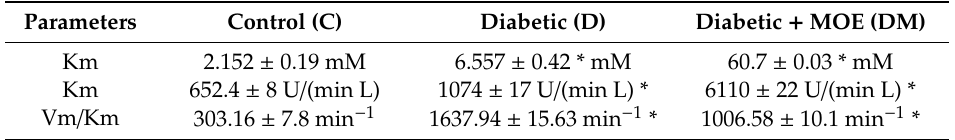
Figure 2. Calculation of Km and Vm from substrate concentration versus time plots. The image shows a representative trace of five repetitions for each rat of a different group. Table 2. Kinetic parameters of rCAT obtained from Lambert W